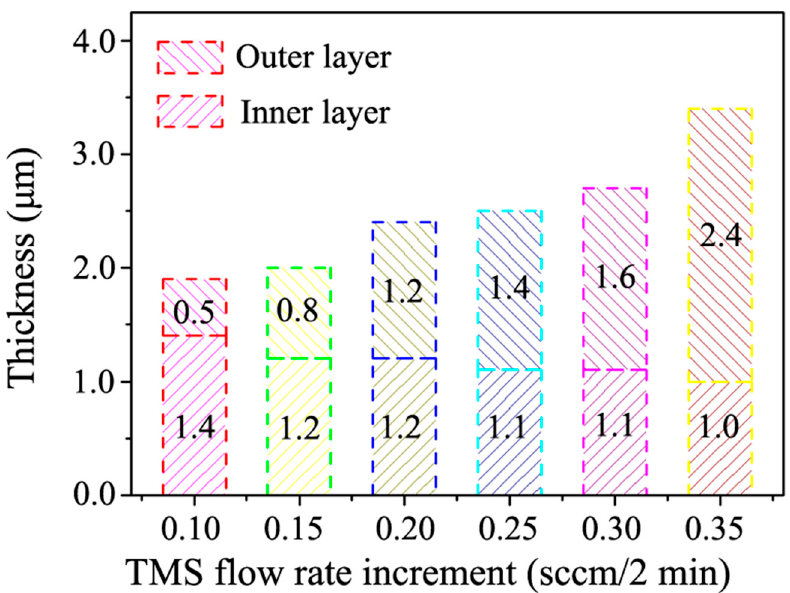
Figure 6. Variation in thickness of HfC-SiC mixed bi-interlayers as a function of TMS flow rate